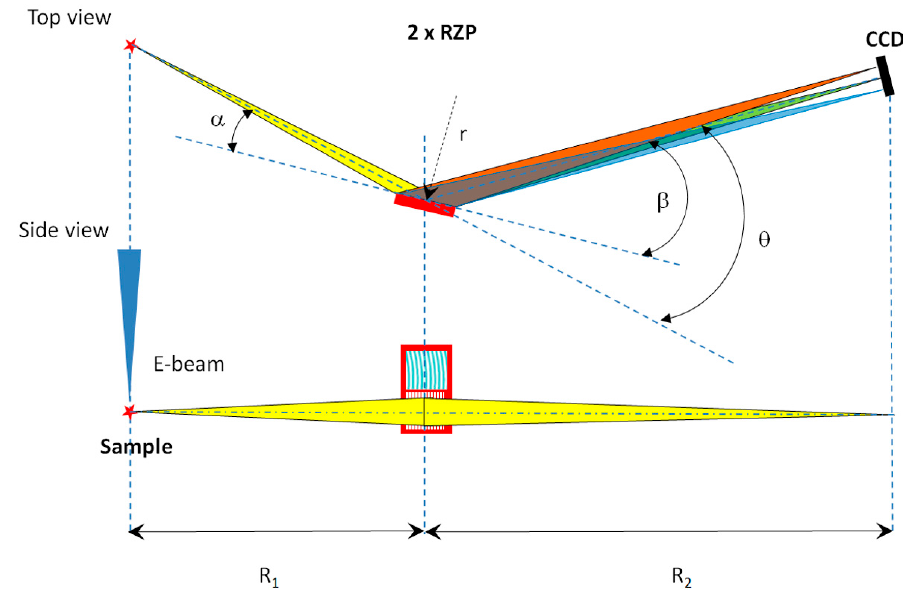
Figure 2. Optical layout of the spectrometer. The spherical substrate (red rectangle) carried two RZPs in a parallel layout, and one of them was used to select the desired energy range. See Table 1 for a definition and specification of the design parameters.